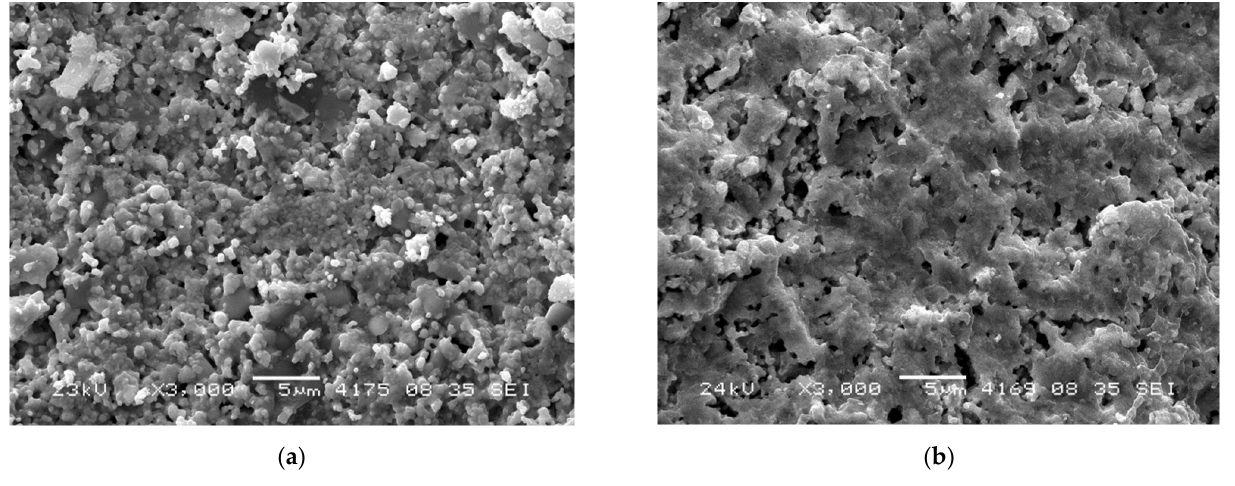
Figure 2. SEM micrographs of the NWO sample obtained by mechanical activation and RTS at 1100 °C acquired from the base ( a ) and the side ( b ) of the pellet.